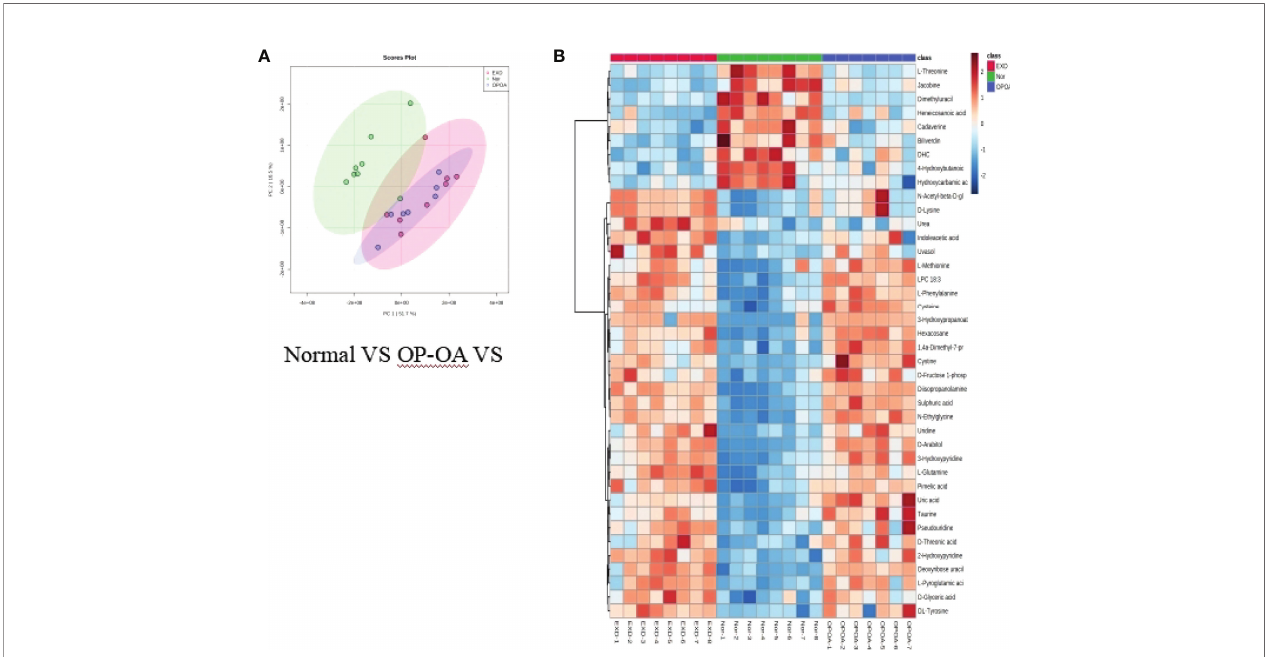
FIGURE 5 | Metabolomics reveals relevant differential metabolites between normal, OP-OA, and EXD. (A) PCA chart of the normal group, OP-OA group, and EXD group. (B) Comparison heat map of differential metabolites in the normal group, OP-OA group, and EXD